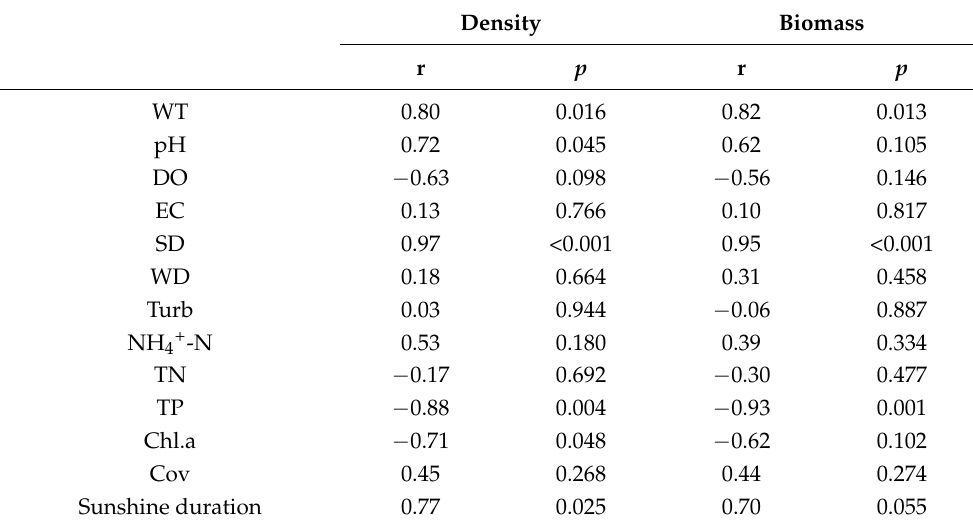
Table 4. Correlation analysis between zooplankton and environmental factors in the period of regular water level fluctuation.